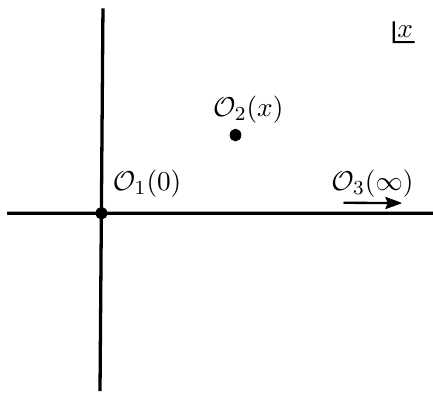
Figure 1. Conformal frame used for three-point functions: hO 1 (0) O 2 ( x ) O 3 ( ∞ ) i